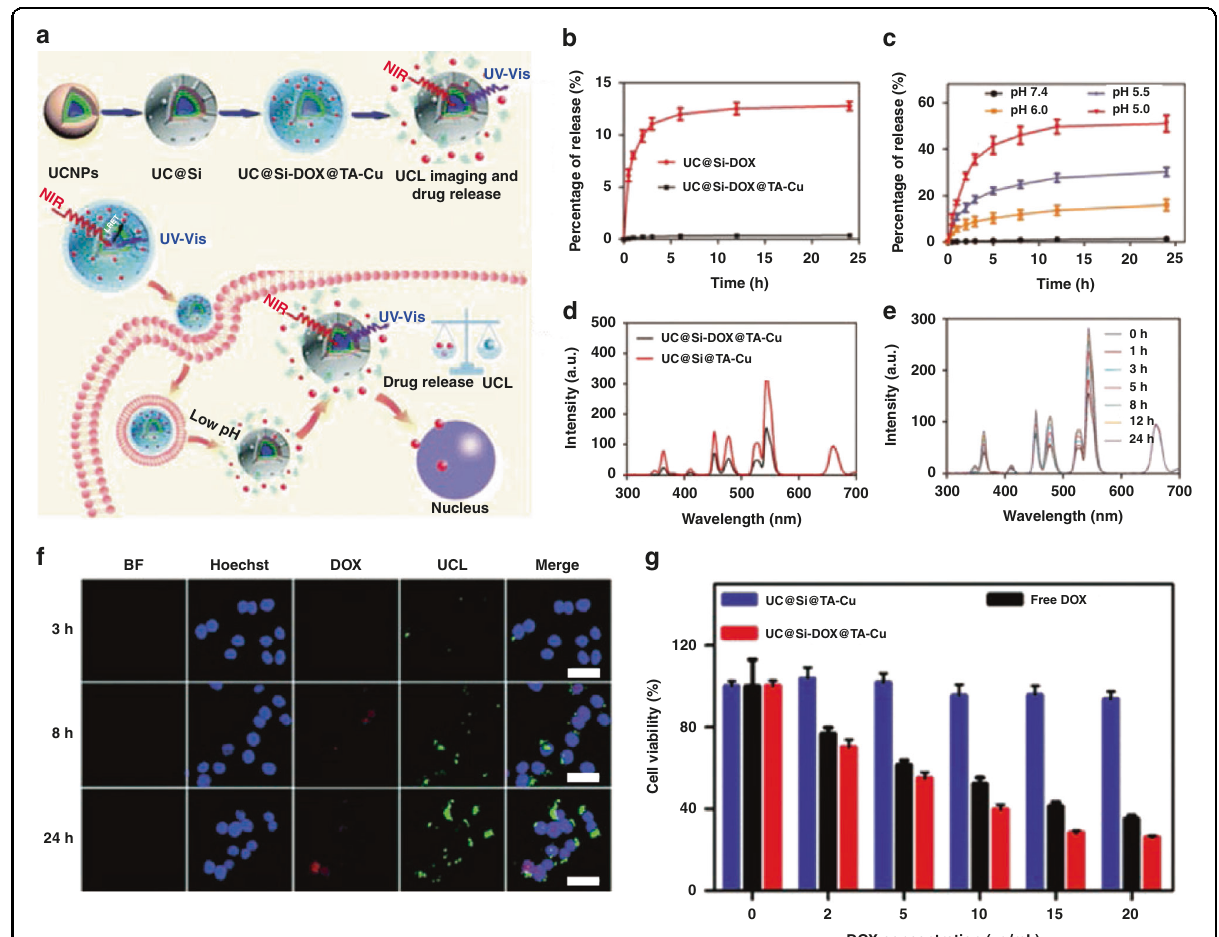
Fig. 6 Chemotherapy. a Schematic illustration of the fabrication of UC@Si-DOX@TA – Cu and pH-responsive drug release monitored by UCL